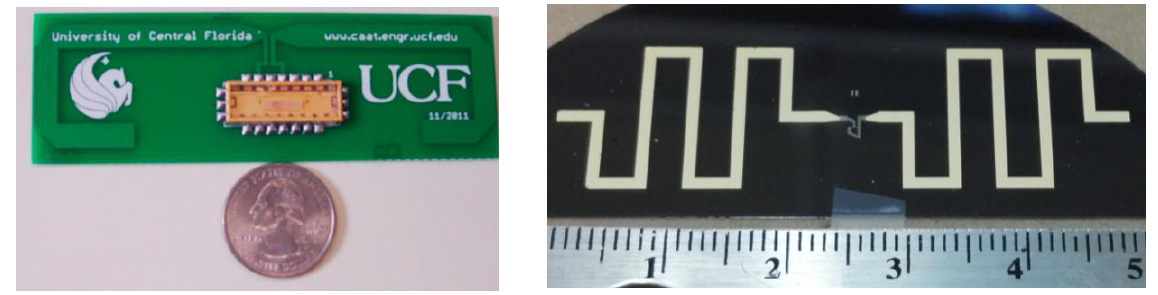
Figure 15. Left—Photo of a packaged 915 MHz SAW sensor and antenna [20]. The antenna is a simple folded dipole on a PCB connected to the device through the surface mount package. Right—Integrated SAW/antenna on black YZ-LiNbO electroplated gold film for the meander-line dipole pattern. The SAW sensor, seen in- between the dipole arms, requires line width resolution of approximately 0.8 µm, compared to the antenna having an order of magnitude larger dimensional resolution. The SAWtenna is rugged and useful for many applications requiring no mechanical bonds